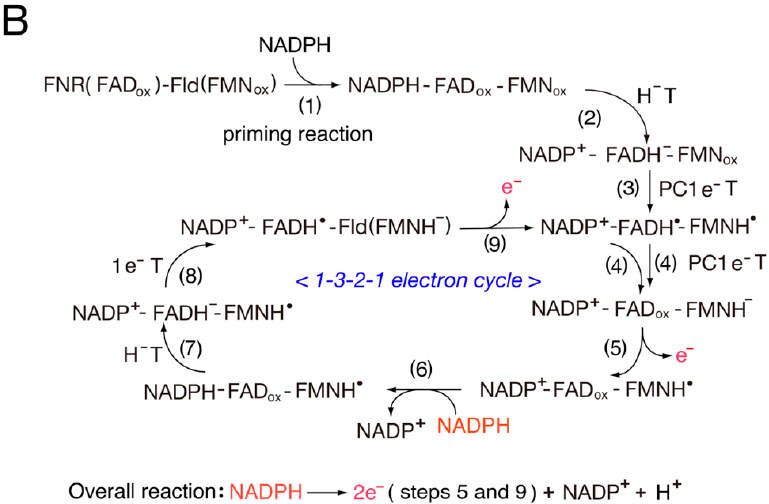
Figure 2. Proposed catalytic cycle of the FNR-Fld systems. ( A ) Photosystem I → Fld (FMN) → FNR (FAD) → NADP + and ( B ) NADPH → FNR (FAD) → Fld (FMN) → metabolic redox pathways. In ( B ), the overall reaction is based on the catalytic cycle.